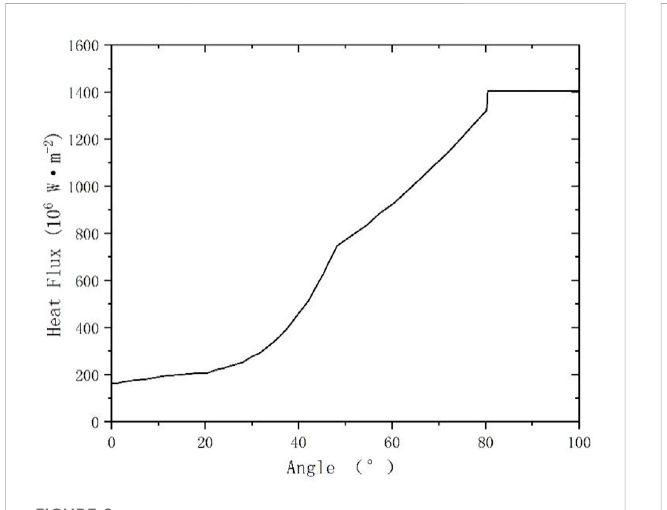
FIGURE 8 RPV inner surface heat fl ux.